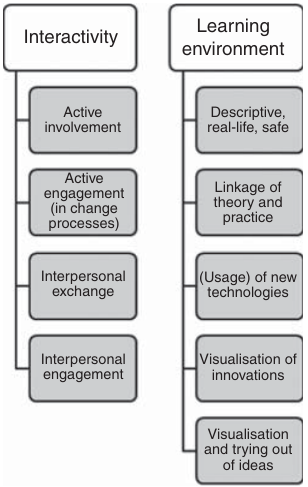
Figure 4. SL Participant ’ s perceived Model Warehouse